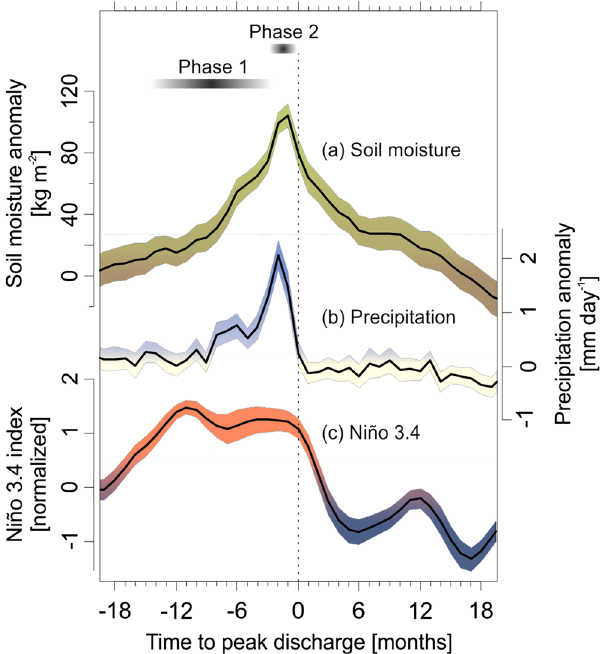
Figure 3. Stacked monthly ( a ) soil moisture anomalies and ( b ) precipitation anomalies over the lower Mississippi basin, and ( c ) the Niño 3.4 index for all simulated extreme floods (n = 116; defined as a peak annual discharge with an exceedance probability ≤ 1%, i.e., a 100-year flood) in the CESM–LME in relation to the time of peak discharge. The mean (line) and 95% confidence interval (colored silhouette) are shown for each variable. The vertical dotted line represents the month of peak discharge; horizontal lines denote a positive anomaly at the p < 0.01 significance level for each variable calculated.